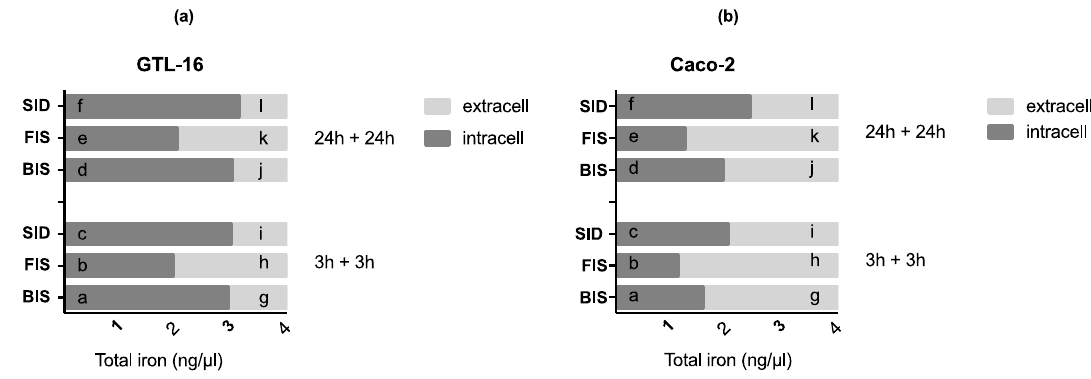
Figure A4. Total iron quantification in GTL-16 ( a ) and Caco-2 ( b ) cells treated with different iron formulations at 3 h plus 3 h and 24 h plus 24 h. The graphs show the iron movements quantified. Results are expressed as mean ± SD of four independent experiments for each cell type. In ( a ) a p < 0.05 vs. b, c, d; b p < 0.05 vs. c; d p < 0.05 vs. e; c, e p < 0.05 vs. f; g p < 0.05 vs. h, i; h p < 0.05 vs. i; j p < 0.05 vs. k; i , k p < 0.05 vs. l. In ( b ), a p < 0.05 vs. b, c, d; b p < 0.05 vs. c; d p < 0.05 vs. e, f; c , e p < 0.05 vs. f; g p < 0.05 vs. h, i, j; h p < 0.05 vs. i; j p < 0.05 vs. k, l; i p < 0.05 vs. l.